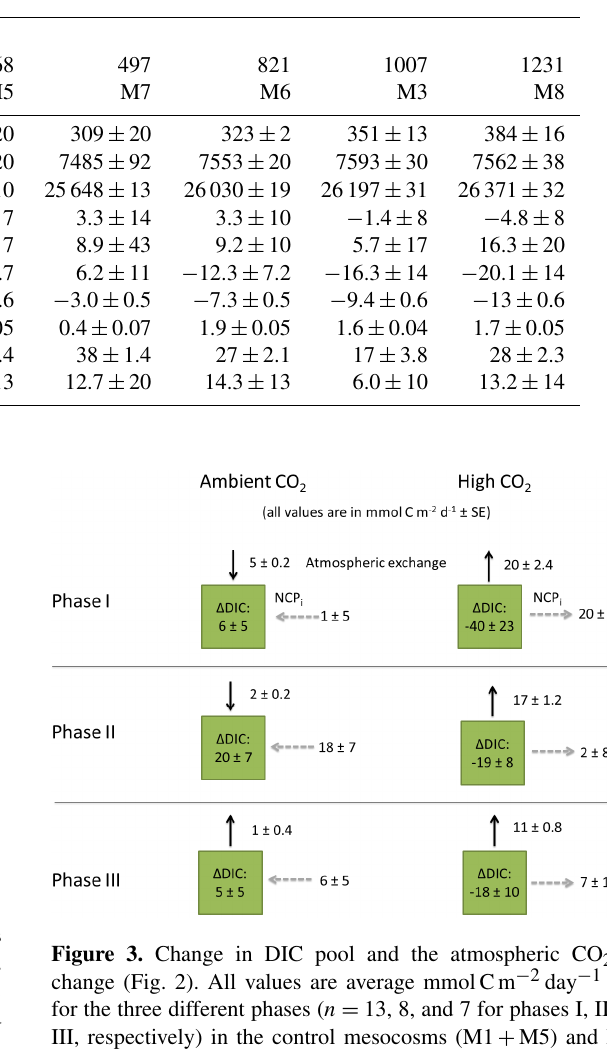
of change in DOC pool (Tables 2 and 3), indicating reduced bacterial uptake and remineralization of DOC. The combined results suggest that the increase in the DOC pool at high CO 2 was related to reduced DOC loss (uptake by bacteria), rather than increased release of DOC by the plankton community, at elevated CO 2